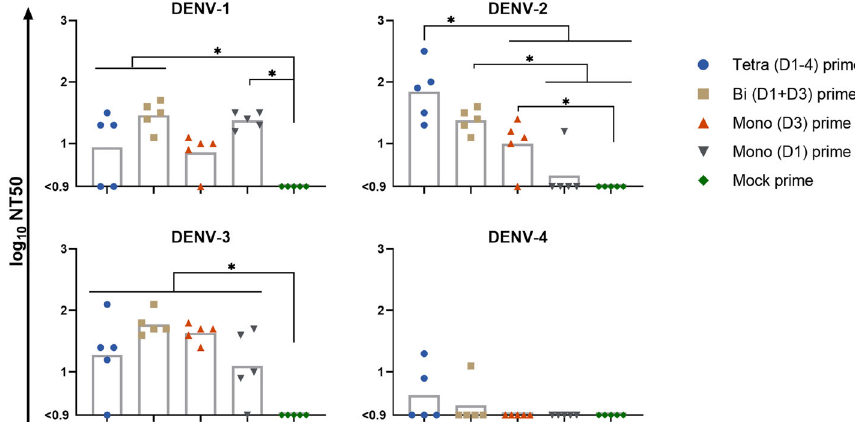
Fig. 3 50% neutralization titers against DENV-1 – 4 of sera from day 28 post-PIV vaccination. Log 10 -transformed data are shown. The lowest dilution tested was 1/8. Bar heights are the geometric means for each group. Data were analyzed using a one-way ANOVA model with Tukey ’ s multiple comparisons test. * p <